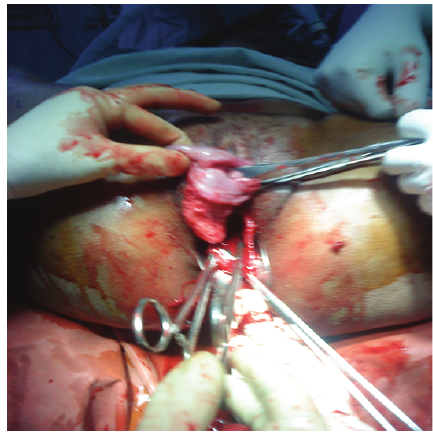
Figure 1: Completely avulsed cervix from lower uterine